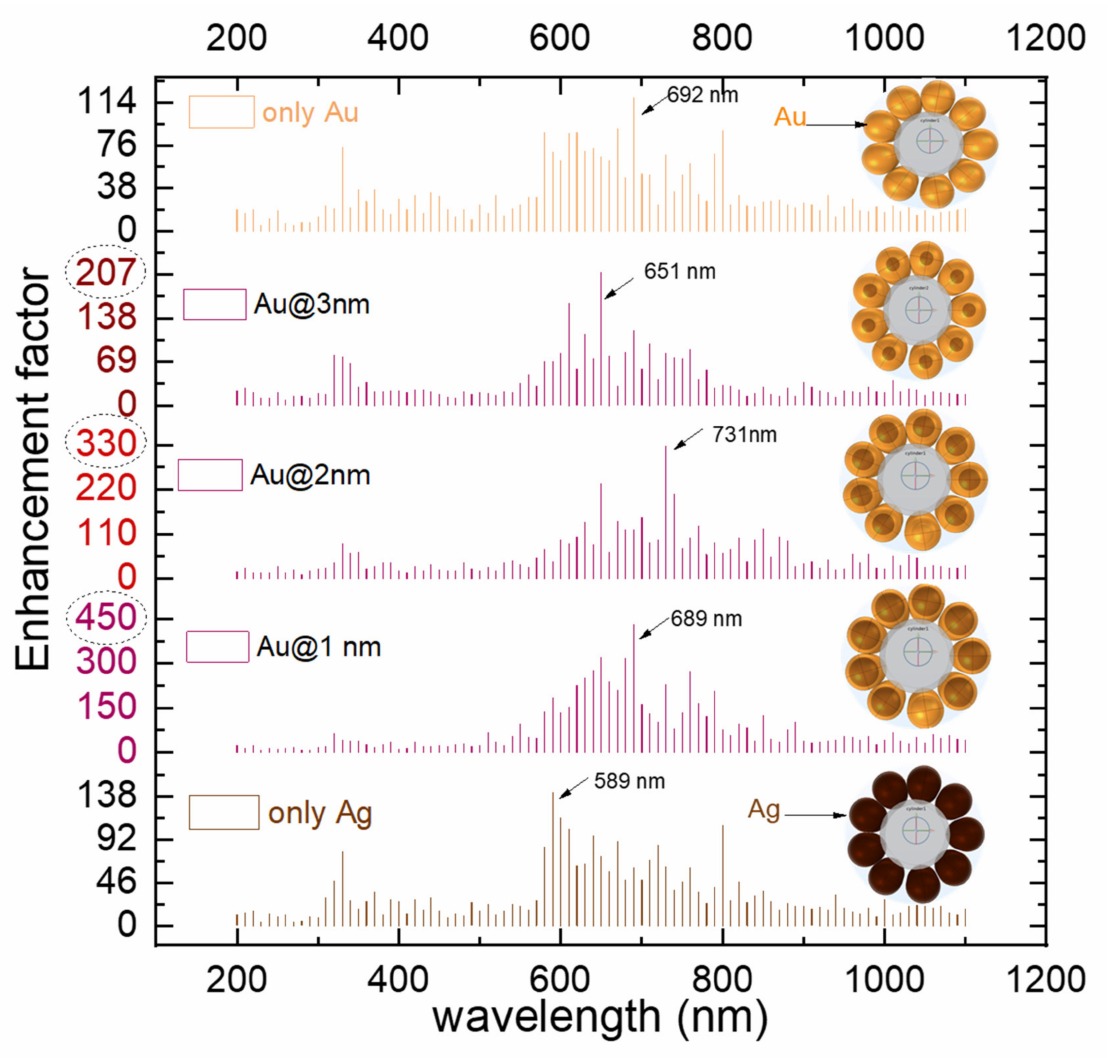
Figure 3. Enhancement factor E loc /E 0 of the Si nanoantenna (7 nm radius, 70 nm length) decorated with (1) only Ag, (2) only Au (3) Ag/Au core-shell (2 nm–3 nm) (4) Ag/Au core-shell (3 nm–2 nm) (5) Ag/Au core-shell (4 nm–1